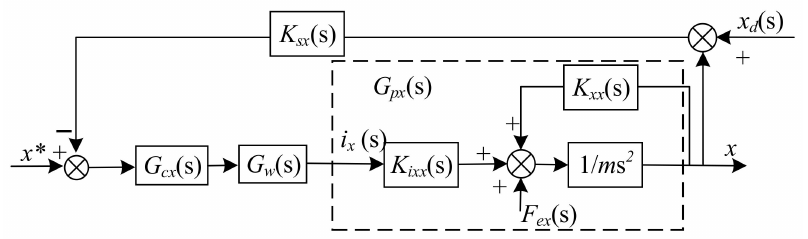
Figure 6. Equivalent control schematic diagram in the x